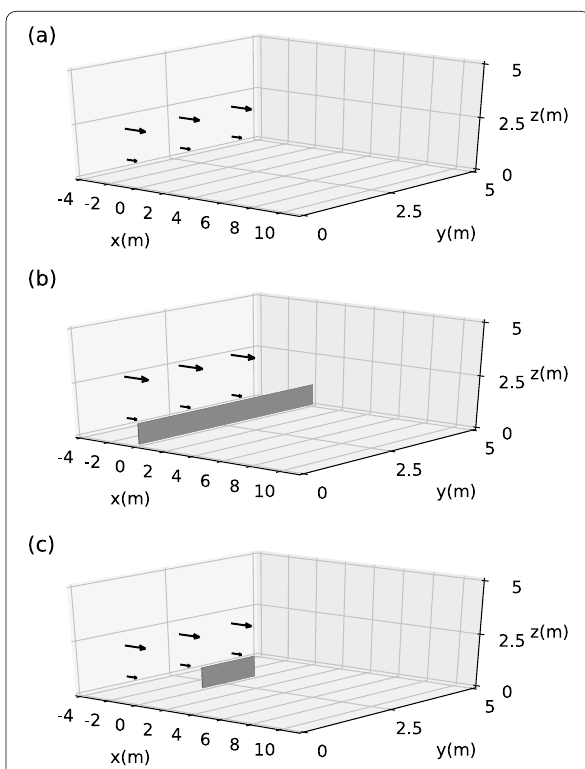
Fig. 2 Schematic of the calculation domain and initial wind vectors in the experiment with a no fence, b a two-dimensional fence, and c a three-dimensional